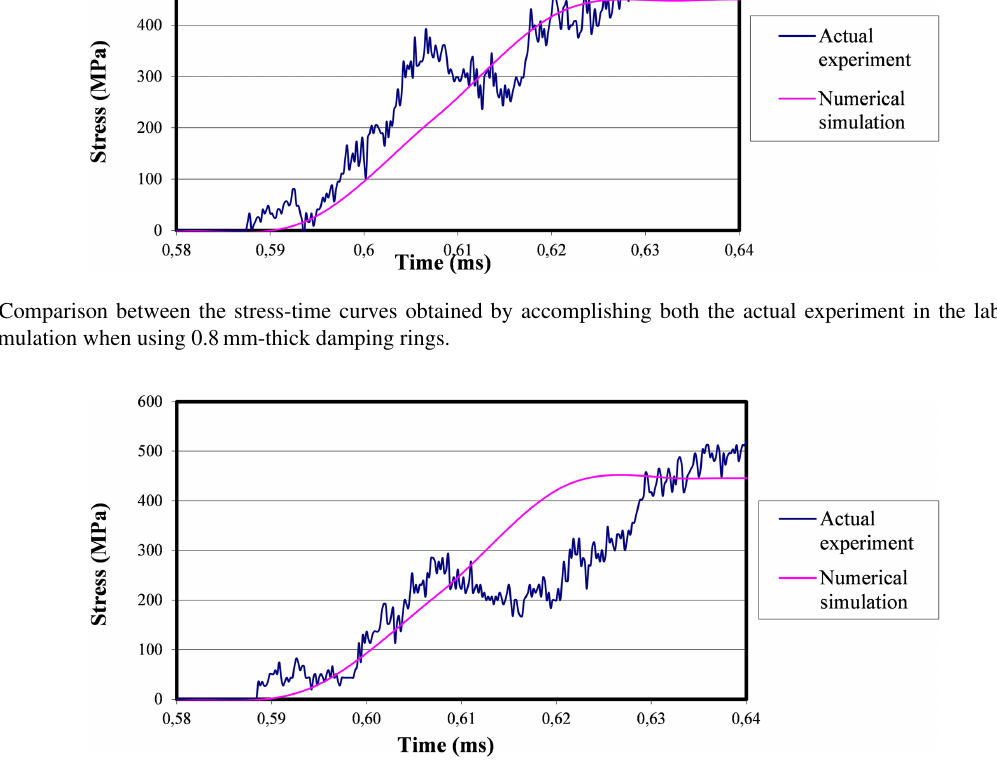
Figure 38. Comparison between the stress-time curves obtained by accomplishing both the actual experiment in the laboratory and the numerical simulation when using 0.5mm-thick damping